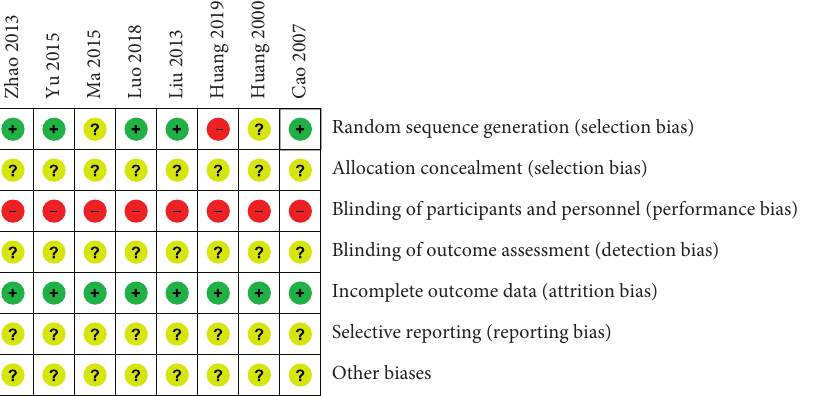
Figure 3: Risk of bias summary: review authors’ judgements about each risk of bias item for each included